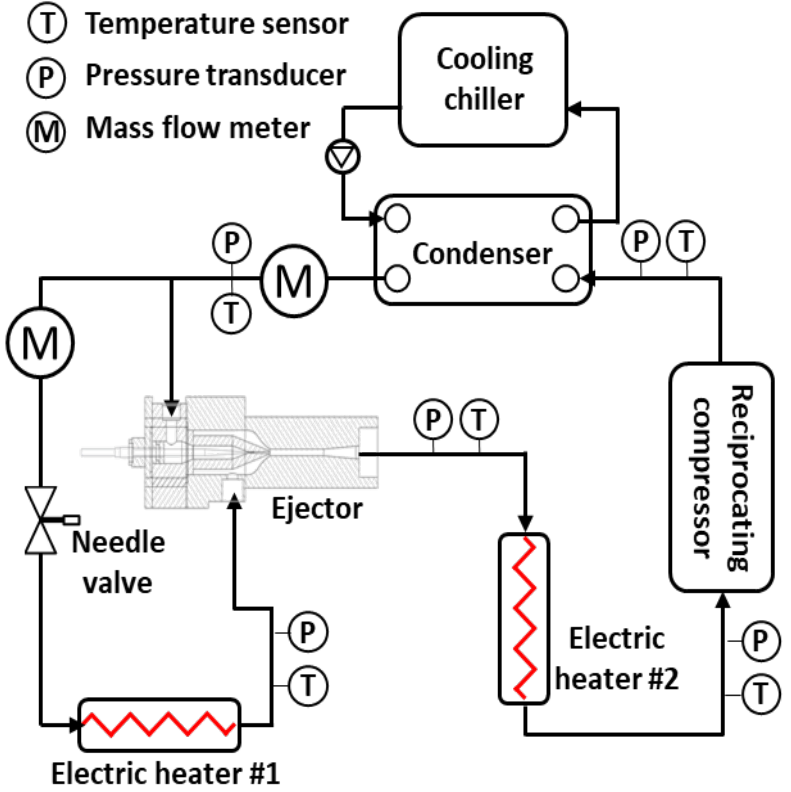
Figure 2. Schematic of the experimental setup of the COS ejector cycle.